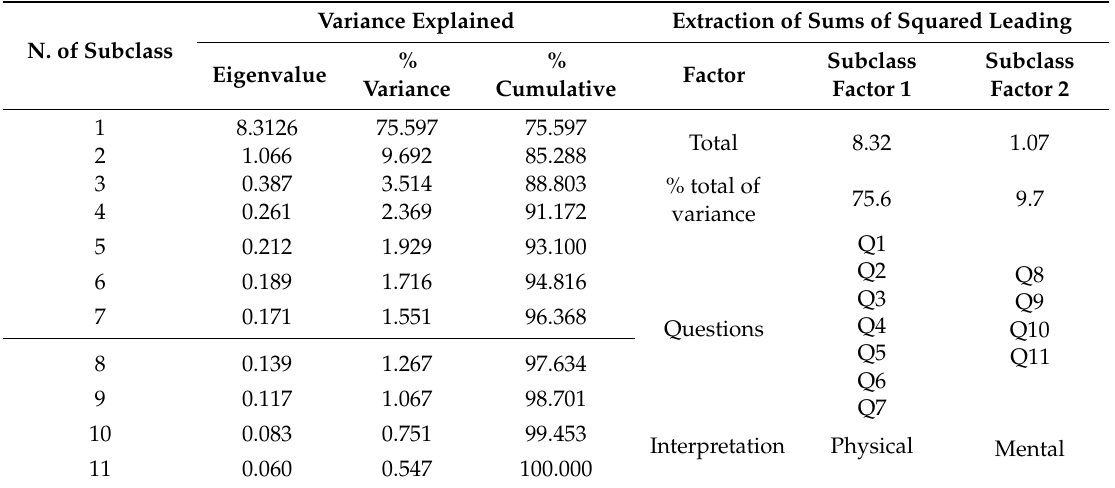
Table 2. Principal component analysis after varimax rotation of the mKCFQ11.